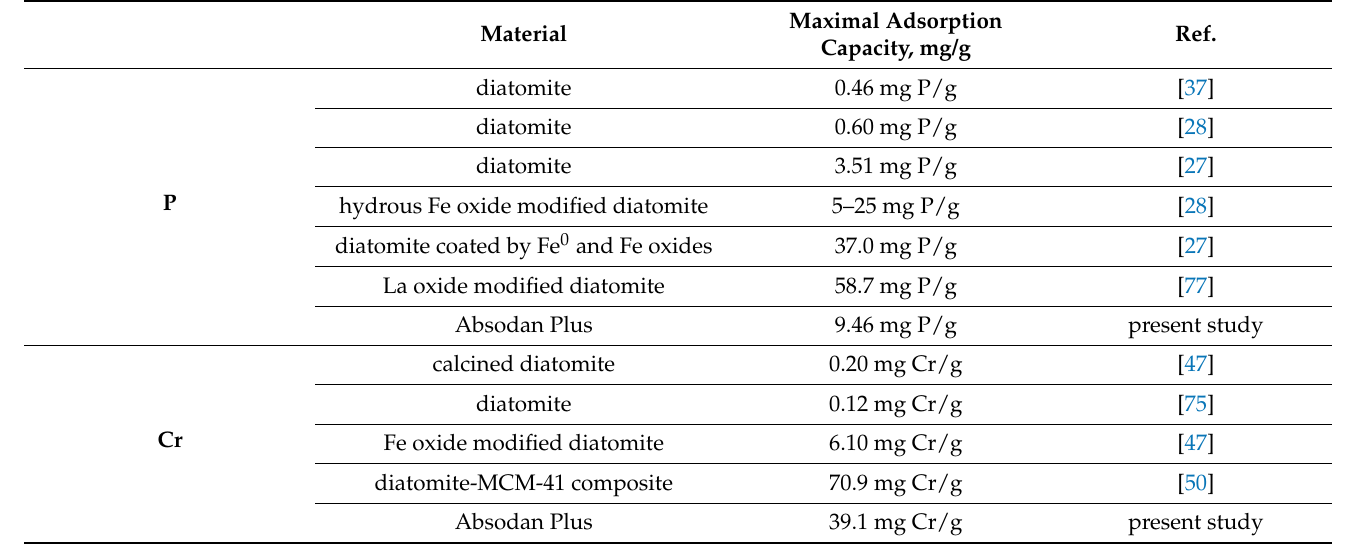
Table 8. The comparison of the adsorption capacity of Absodan Plus with capacities of various diatomaceous